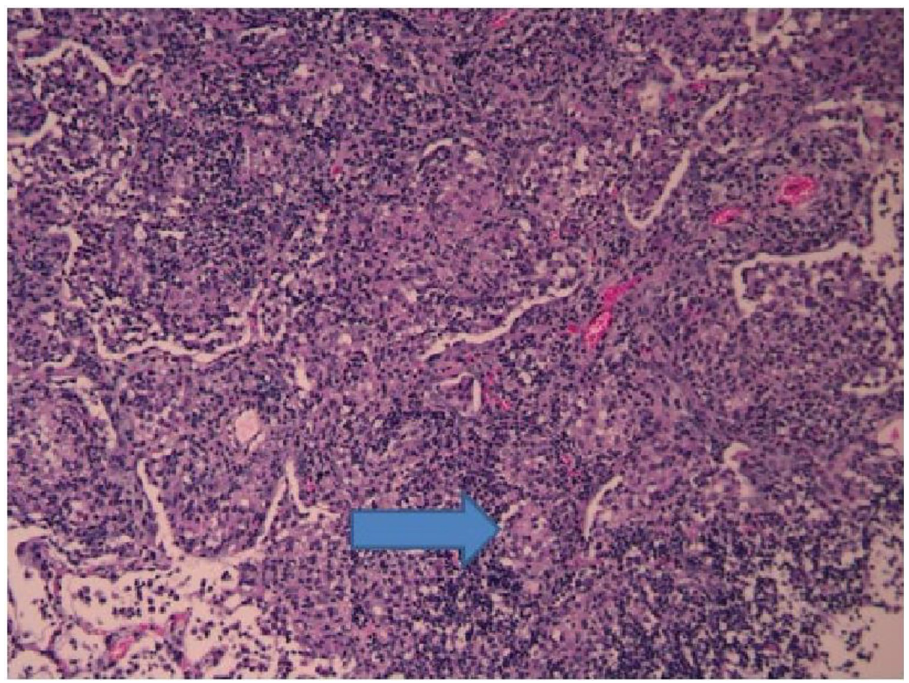
Fig 3. Animal #2, day 30 histology taken from the right middle lobe showing early granuloma with giant cells, mixed lymphocytic/monocytic infiltration with occasional neutrophils and eosinophils. Similar findings with numerous granulomas were identified in much of the right lower